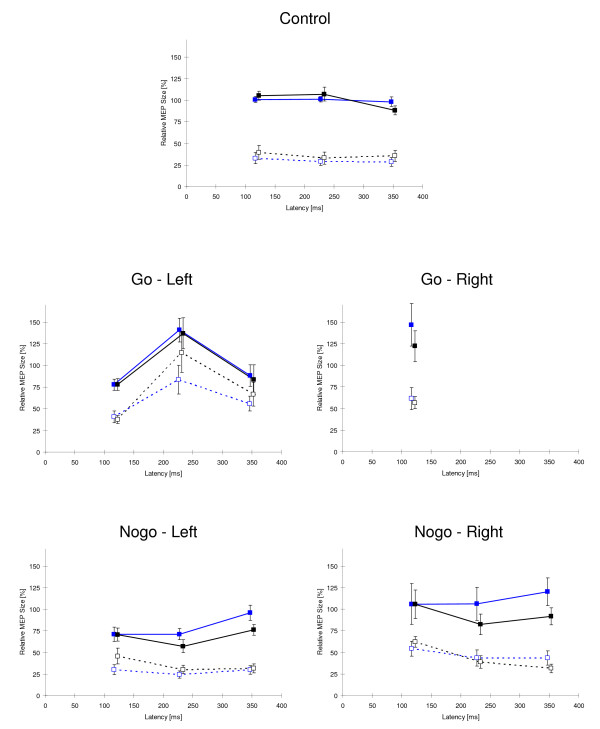
Relative MEP amplitudes in control, go and nogo conditions. Relative MEP amplitudes ± SE in control (top), go (middle) and nogo conditions (bottom). The interval between the S2 stimulus and the TMS pulse in milliseconds is plotted against the x-axis ("latency"), the y-axis describes the resulting amplitude as percentage of the mean values of the respective control condition. Black: placebo, blue: MPH; filled squares: single-pulse responses, open squares: double-pulse responses (ISI 3 ms).